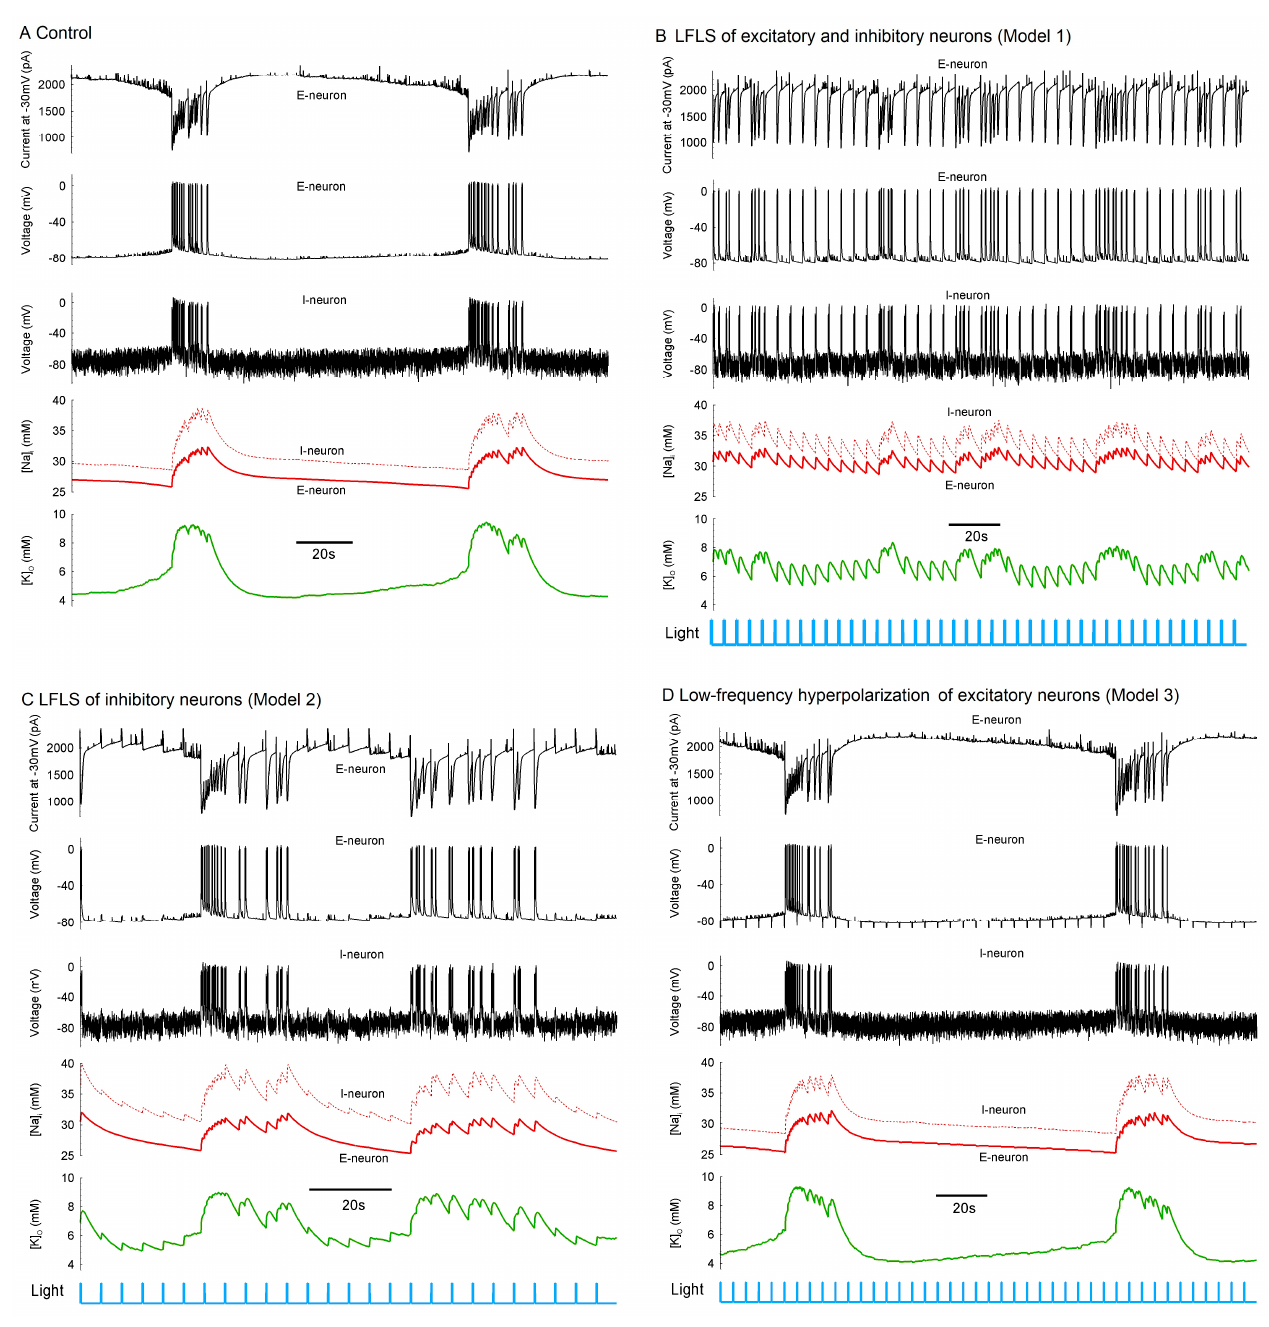
Figure 8. Effect of the LFLS of neurons in the mathematical model of epileptiform activity. ( A ) Spontaneously repeating ictal discharges in the control case. ( B – D ) To simulate the effects of LFLS as seen in experimental Models 1–3, the following current step pulses were injected: ( B ) depolarizing pulses of 25 pA in both excitatory (E) and inhibitory (I) neurons for Model 1; ( C ) depolarizing pulses of 100 pA in I neurons for Model 2; and ( D ) hyperpolarizing pulses of 25 pA in E neurons for Model 3. The signals from top to bottom are as follows: the current measured in a single E neuron in a voltage clamp at − 30 mV; the membrane potentials of E and I neurons; the intracellular concentration of sodium ions; and the extracellular concentration of potassium ions.